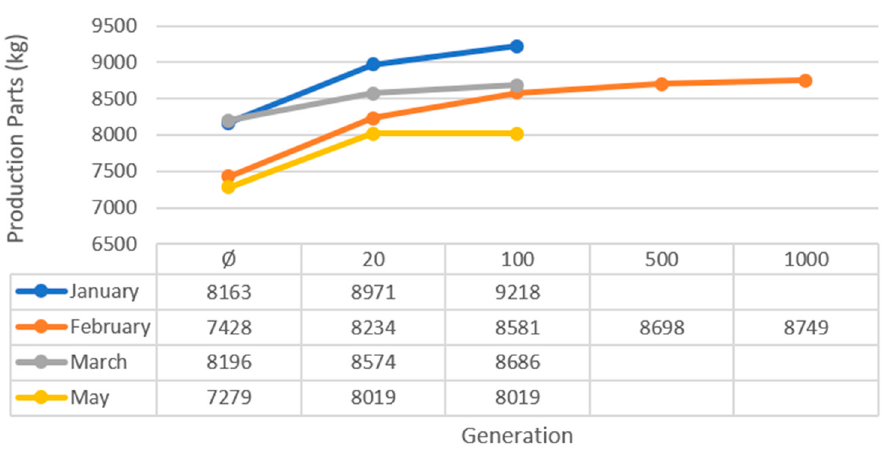
Figure 7. Evolution of the results by different GA generations.